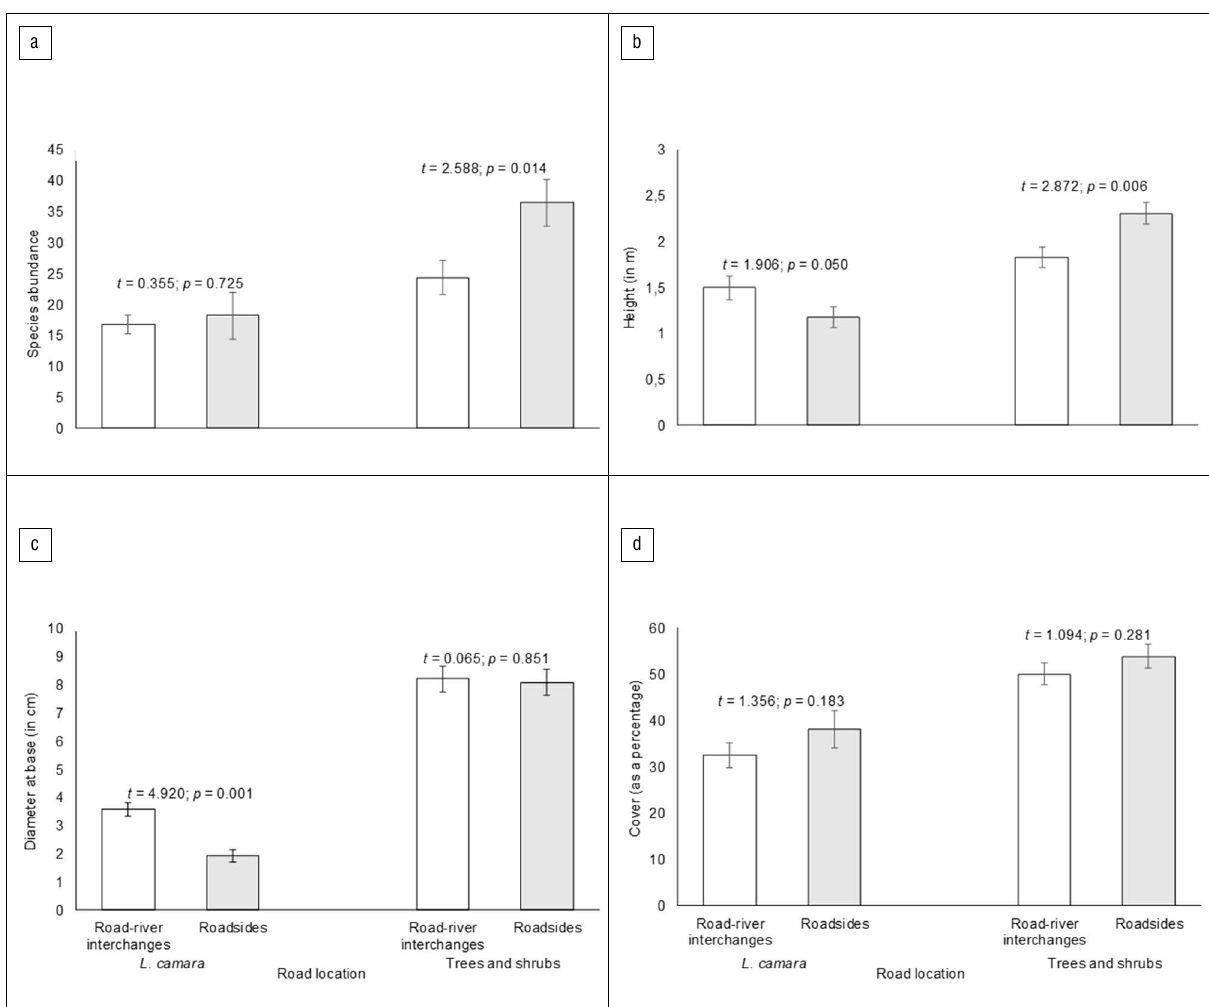
Figure 2: Comparison of (a) species abundance, (b) height, (c) diameter at base and (d) cover for L. camara and other trees and shrubs at different road locations. Data are means ± s.e. and t -test results are